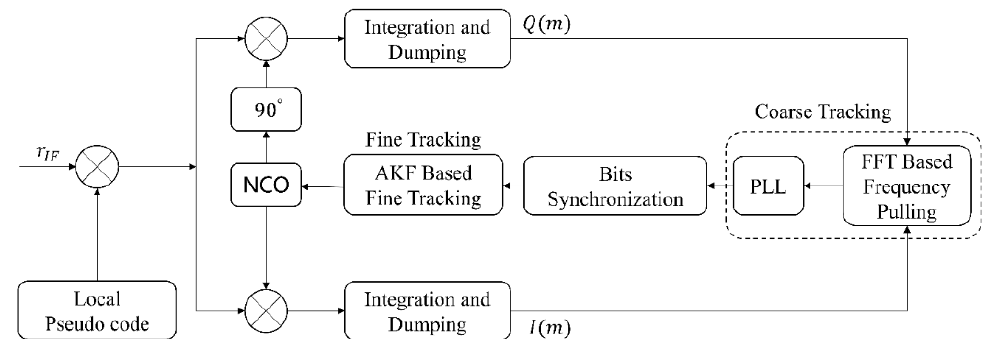
Figure 4. Structure of the proposed coarse-to-fine WAKF-based carrier loop.